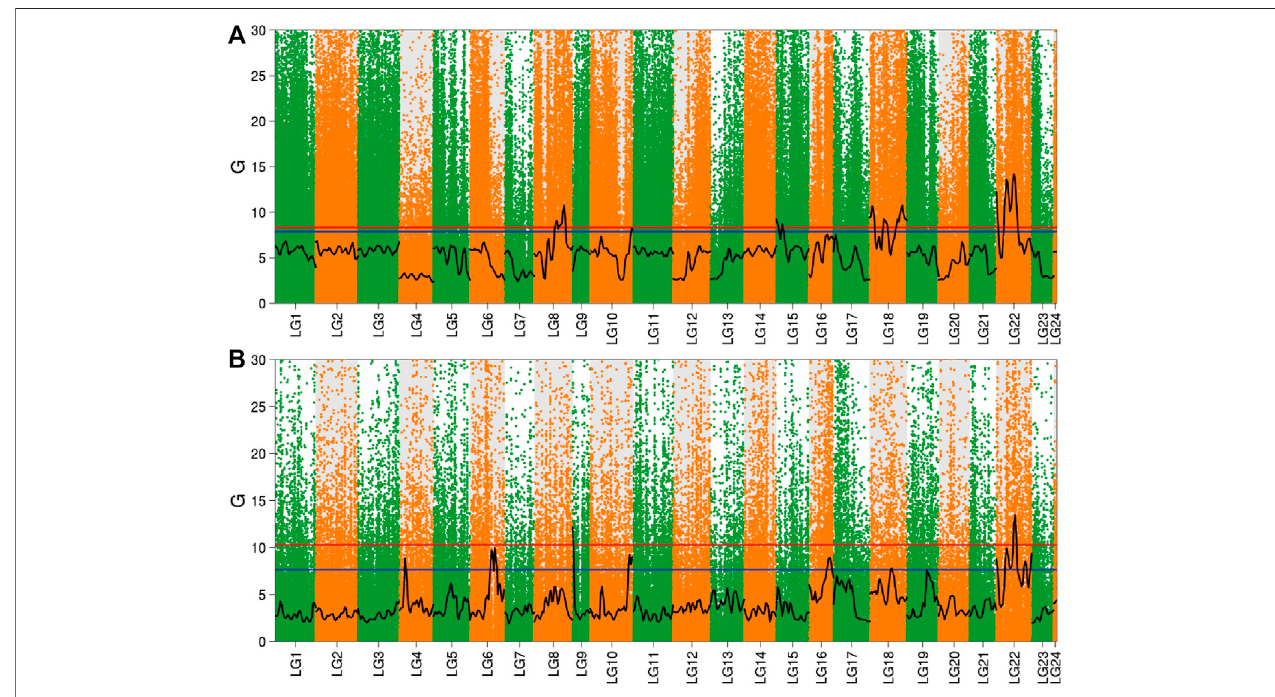
FIGURE 4 | Distribution of G value in the brain and liver. Note: (A) Brain; (B) Liver; The red line in the fi gure is the 99% con fi dence level line, and the blue line is the 95% con fi dence level line.